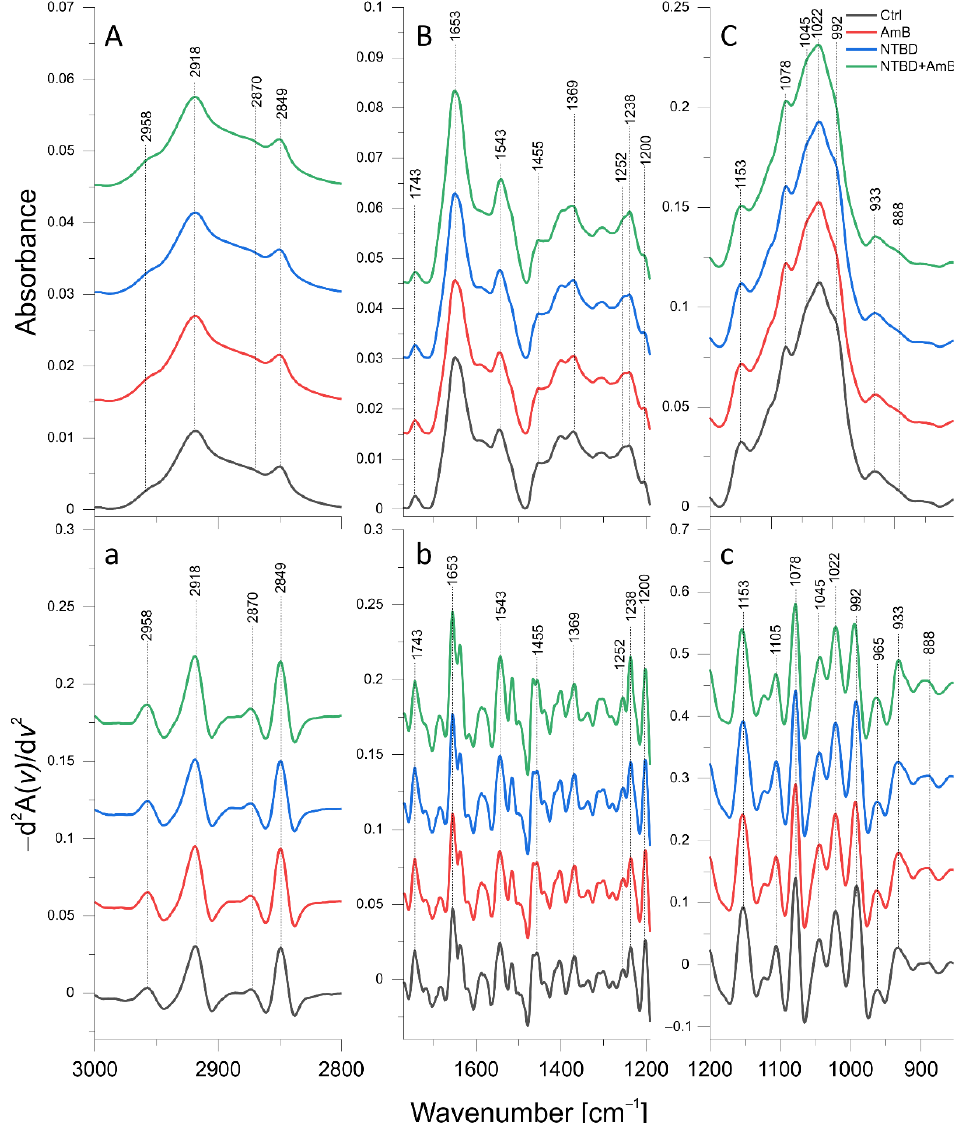
Figure 6. Mean ATR-FTIR spectra of control C. albicans cells and cells treated with AmB (0.06 µg/mL), NTBD (4 µg/mL), and their combination: ( A )—3000–2800 cm − 1 region of ATR-FTIR spectra; ( B )—1750–1190 cm − 1 region of ATR-FTIR spectra; ( C )—1200–800 cm − 1 region of ATR- FTIR spectra; a–c—reversed second derivatives of spectra presented in ( A – C ).